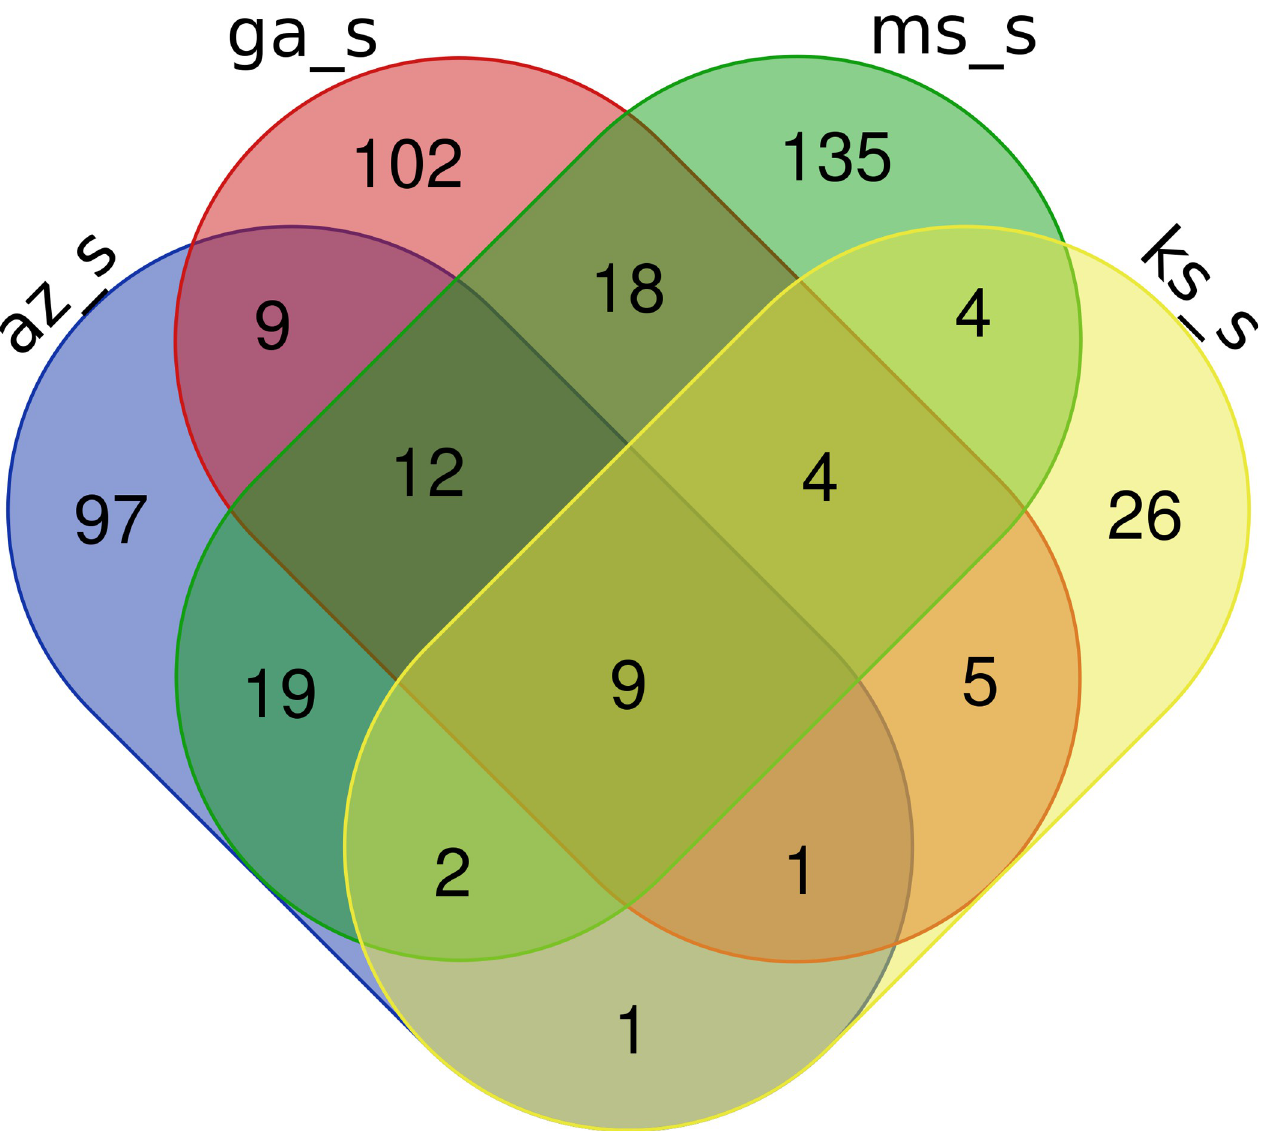
Fig 2. Venn diagram of PFAM elements shared by GS eccDNA samples. Arizona (az_s), Georgia (ga_s), Kansas (ks_s), and Mississippi (ms_s) sensitive A. palmeri eccDNA shared 9 total PFAM elements.